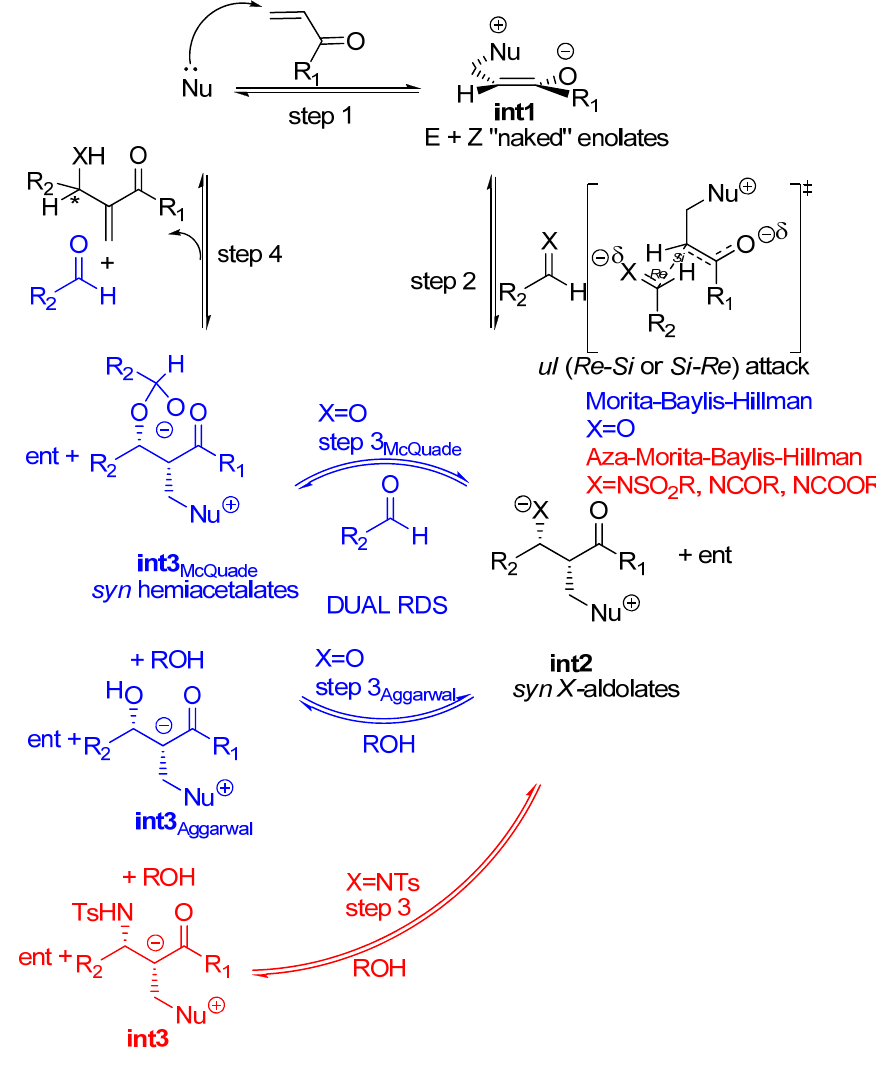
Scheme 7. Stereochemical issues for the standard MBH (dual mechanism) and aza-MBH (single mechanism)